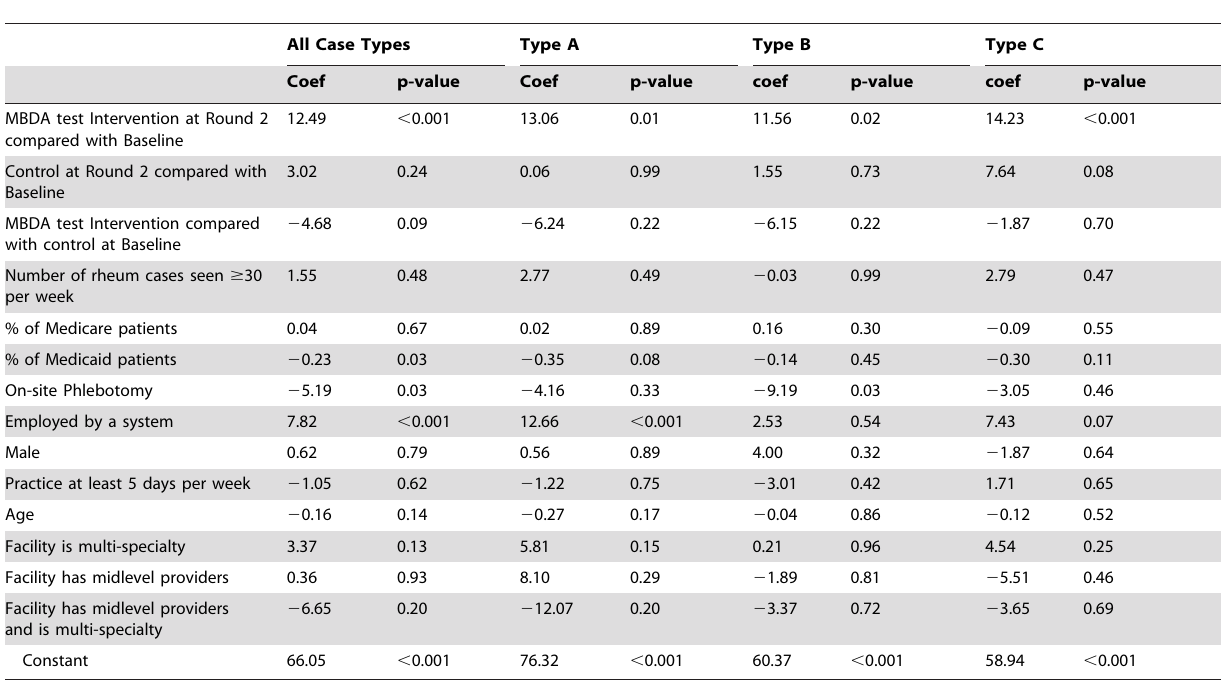
Table 3. Multiple Linear Regression Models of CPV Disease Assessment and Treatment Scores by Case Type for All Cases and for Each Case Type.